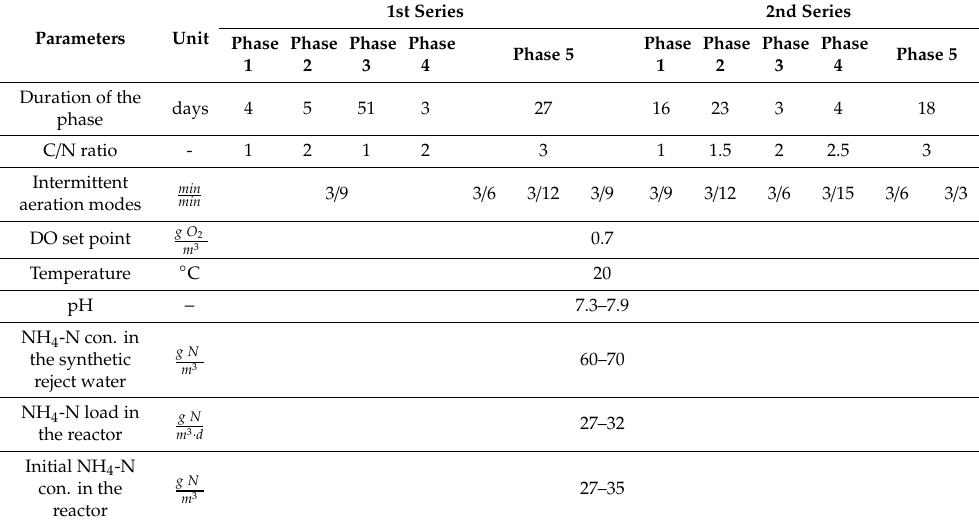
Table 1. Operational parameters, C / N ratios and aeration strategies during following series of deammonification